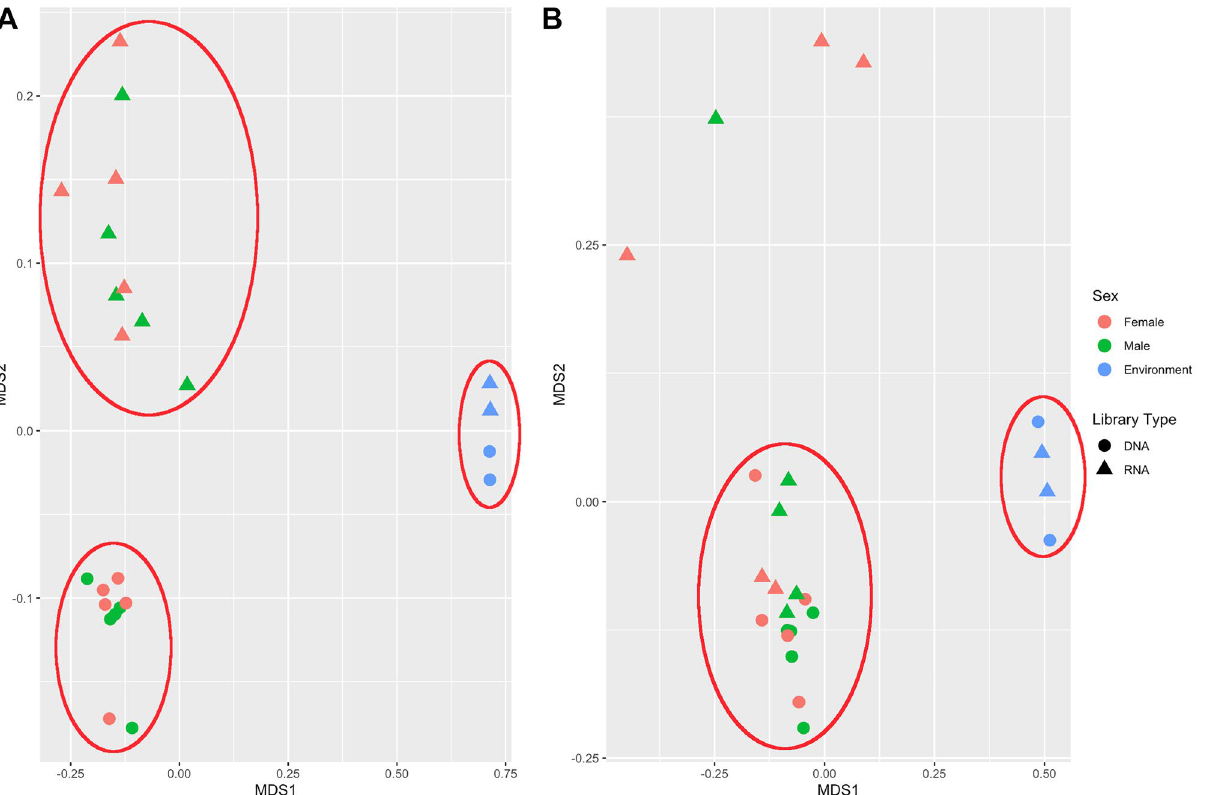
Figure 5. Composition of ( A ) bacterial and ( B ) archaeal community, displayed by non-metric multidimensional scaling (NMDS). Clustering samples are encircled. Colour code: green—male, red—female, blue—sea water. Filled circle—DNA samples, filled triangle—RNA